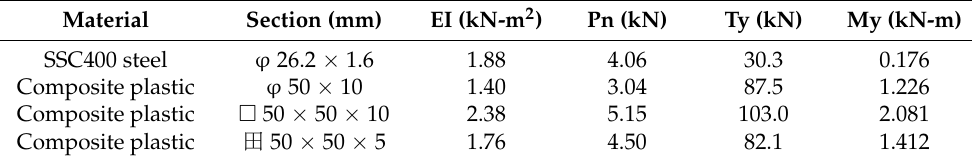
Table 2. Comparison of sectional properties and